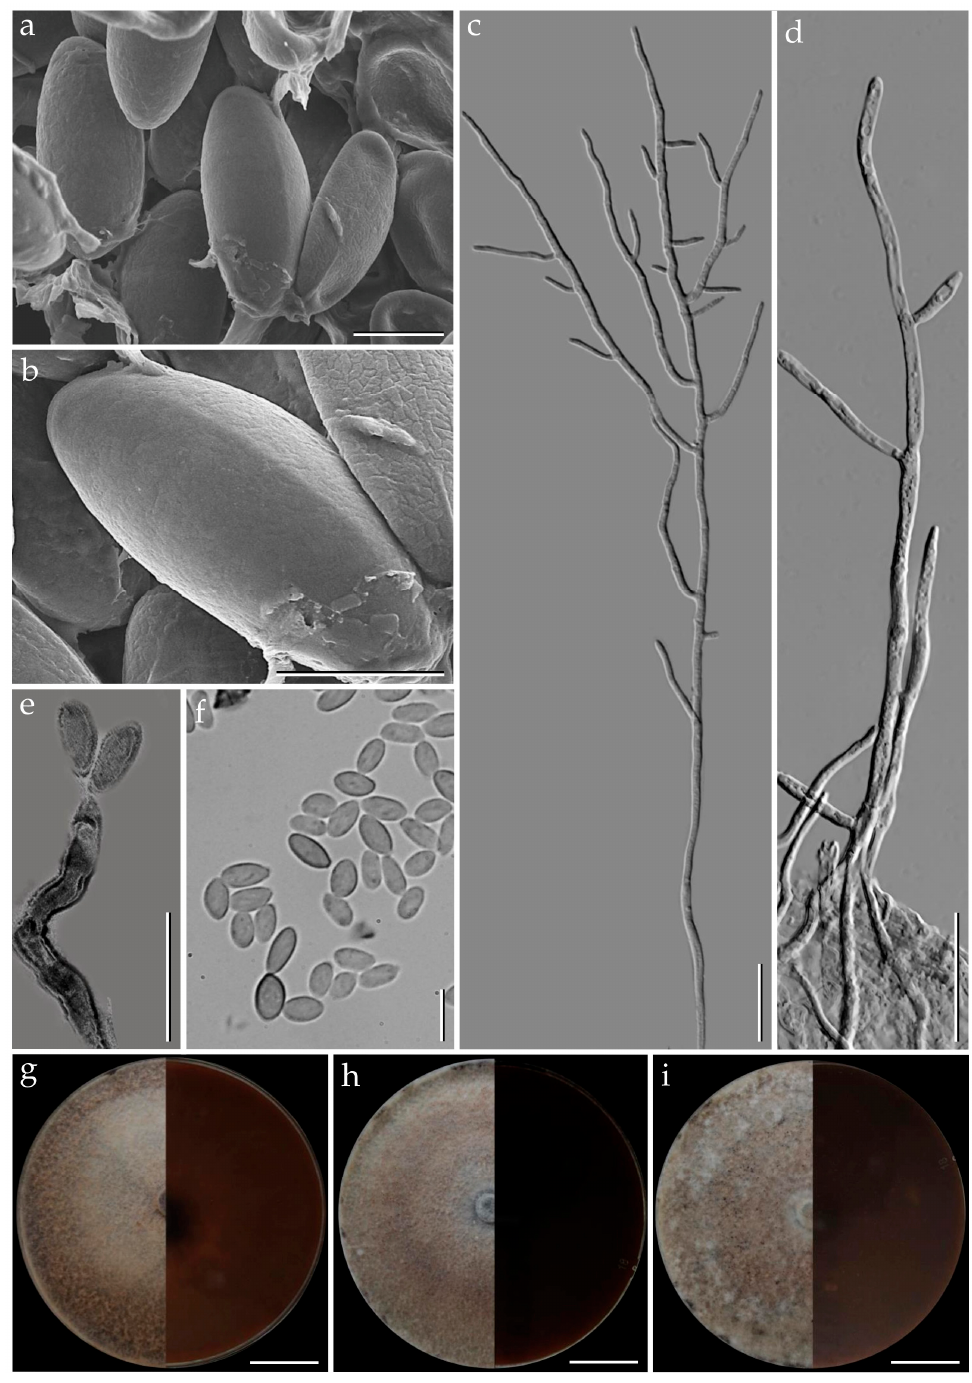
Figure 7. Pyrenopolyporus cinereopigmentosus strain BCC89382. ( a , b ) Ascospores by SEM; ( c , d ) aerial mycelium showing branching pattern; ( e ) conidiogenous cell; ( f ) conidia; ( g ) colony on PDA after one month; ( h ) colony on OA after one month; ( i ) colony on YMGA after on month. Scale bars: ( a , b ) = 5 µm; ( c , d ) = 20 µm; ( e , f ) = 10 µm; ( g – i ) = 2 cm. Secondary metabolites. Stromata contain hypoxylone ( 1 ), BNT ( 2 ), two isobaric unknown compounds ( 4 : [M + Na] + = 258.10997 Da; C 13 H 17 NO 3 ), and other unknown metabolites ( 5 : [M + H] + = 633.45371; C 30 H 60 N 6 O 8 ) as major constituents (Figure S7 and Table S2).